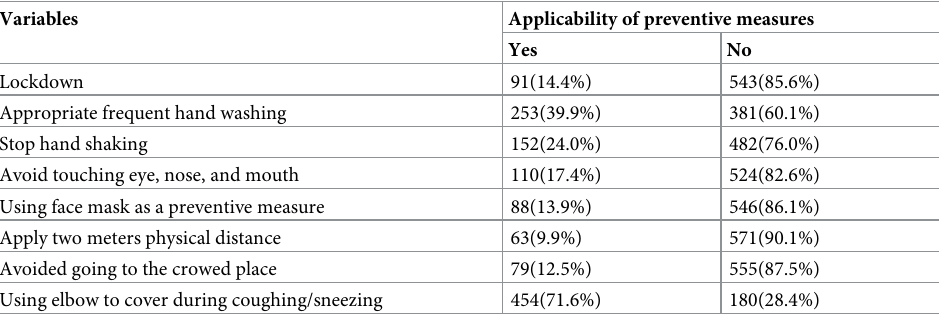
Table 4. The applicability of the basic preventive measures of the pandemic COVID-19 among residents in Gur- aghe Zone, 2020 (n = 634).